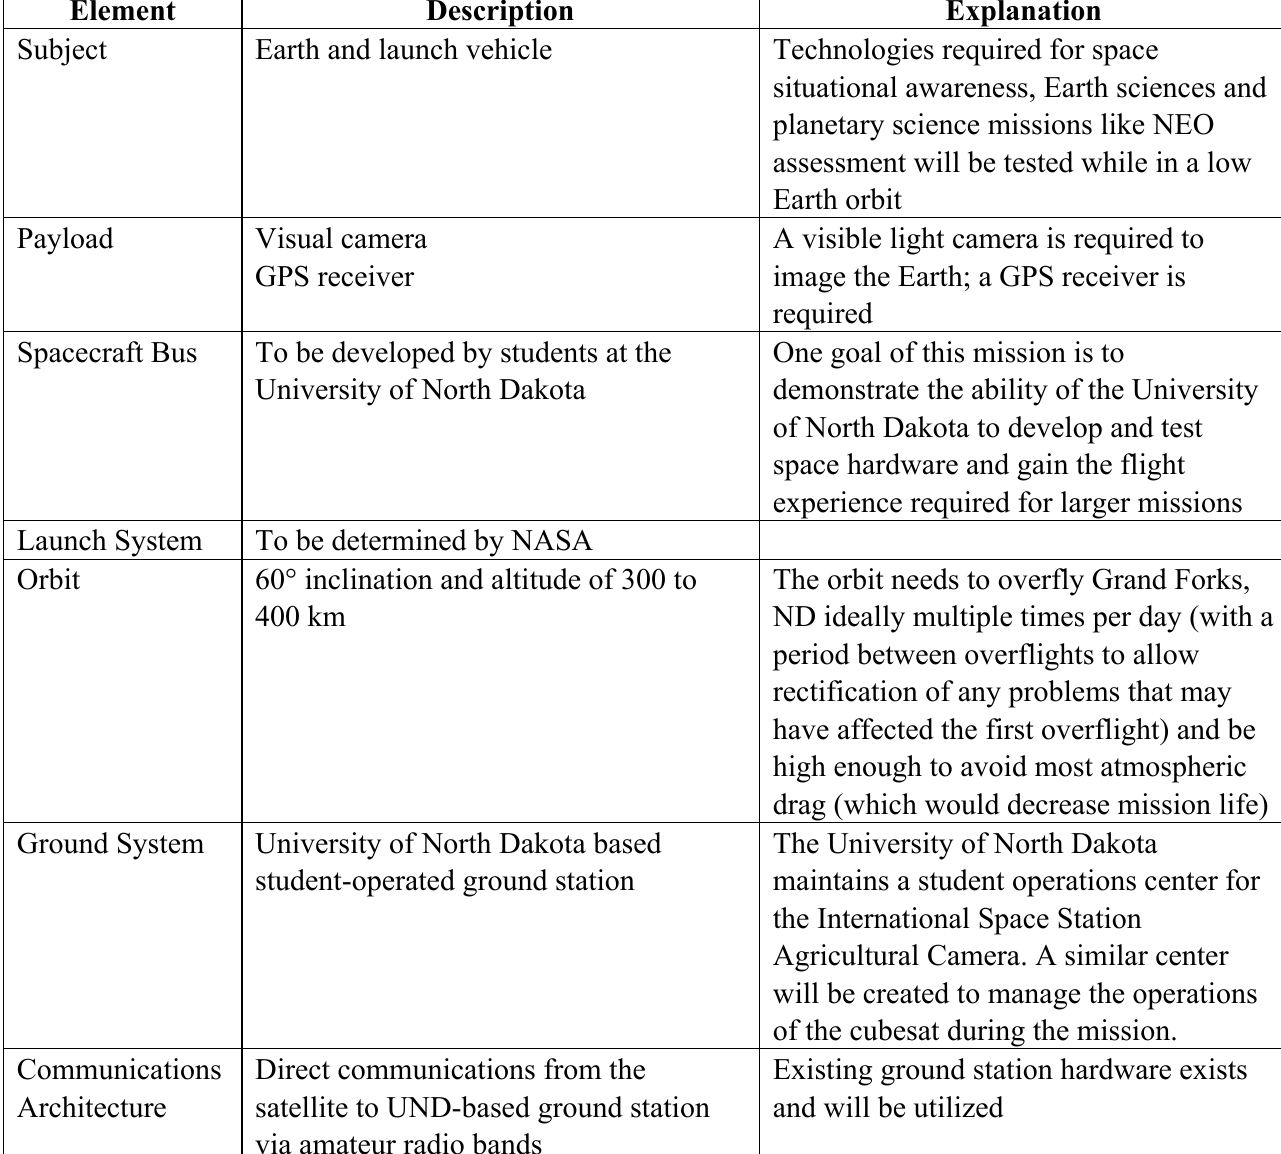
Table 3. Mission